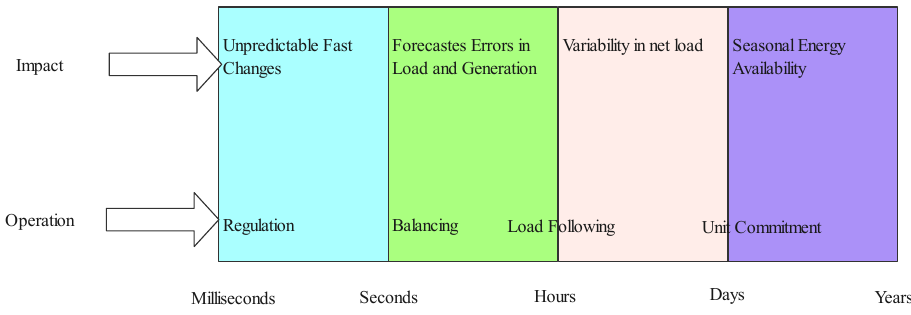
Figure 4. PSF analysis considering